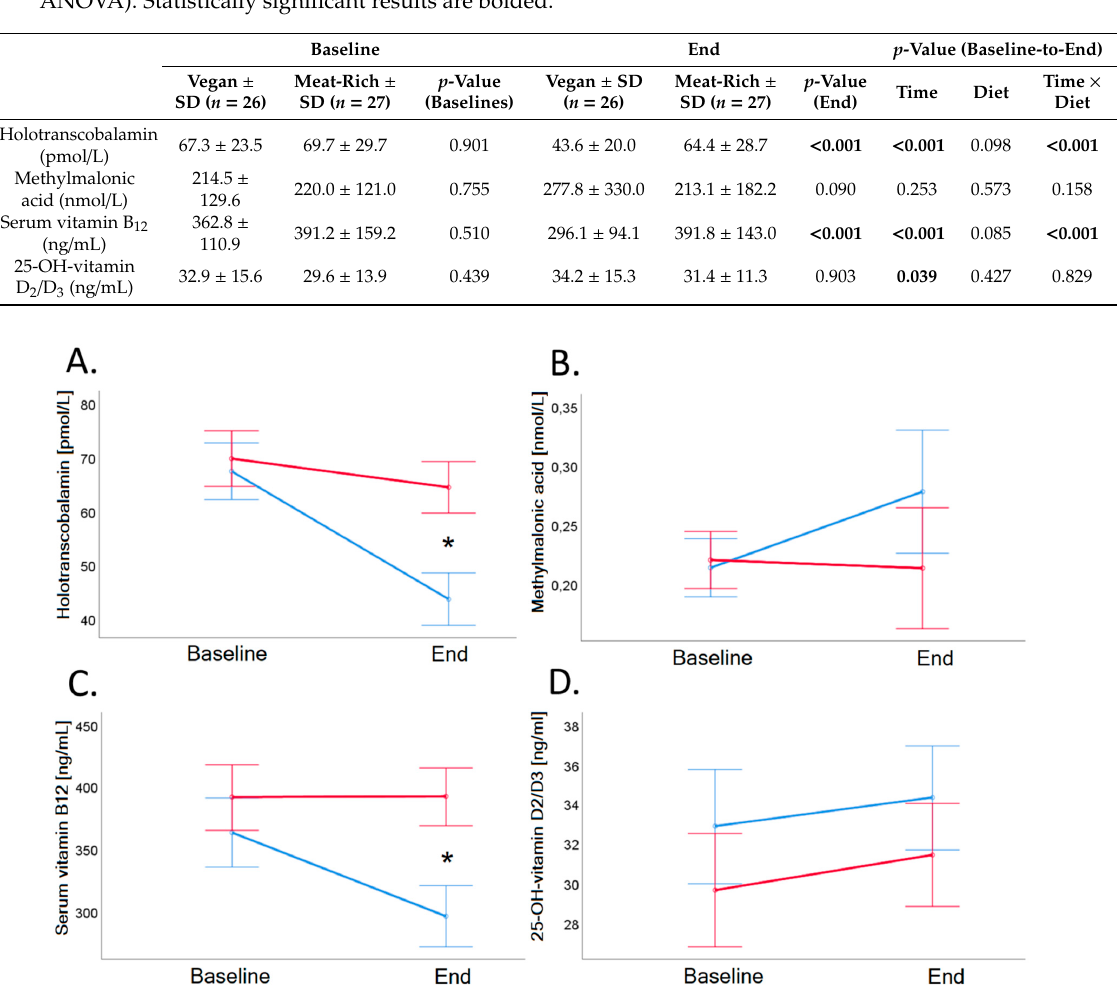
Figure 3. Holotranscobalamin (Panel A ), methylmalonic acid (Panel B ), vitamin B 12 (Panel C ), and 25-OH-Vitamin D 2 / D 3 (Panel D ) in serum before and after 4-week dietary intervention in VD (blue line) and MD (red line). Serum vitamin B 12 (ng / L) and holotranscobalamin concentrations (pmol / L) showed a significantly decrease in vegans (vitamin B 12 : 362.8 ± 110.9 to 296.1 ± 94.1 ng/L, p < 0.001; holotranscobalamin: 67.3 ± 23.5 to 43.6 ± 20.0 pmol/L, p < 0.001) compared to meat-rich subjects (vitamin B 12 : 391.2 ± 159.2 to 391.8 ± 143.0 ng/L, p = 0.919; holotranscobalamin: 69.7 ± 29.7 to 64.4 ± 28.7 pmol/L, p = 0.041). Holotranscobalamin decreased by more than 30% upon dietary intervention, whereas serum vitamin B 12 decreased by 18% . Error bars show ± 1 standard error. Baseline and end values as well as statistical comparisons are shown in Table 2. Significant di ff erences between groups are marked with an asterisk (*: p <